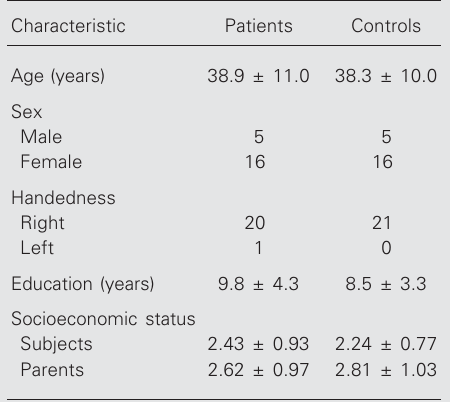
Data are reported as means ± SD for N = 21 in each group. Handedness was assessed by the Edinburgh Inventory (9). Classification of socioeconomic sta- tus was based on the modified Critério de Classifi- cação Sócio-Econômica Brasil (10). The lower the number, the higher the socioeconomic